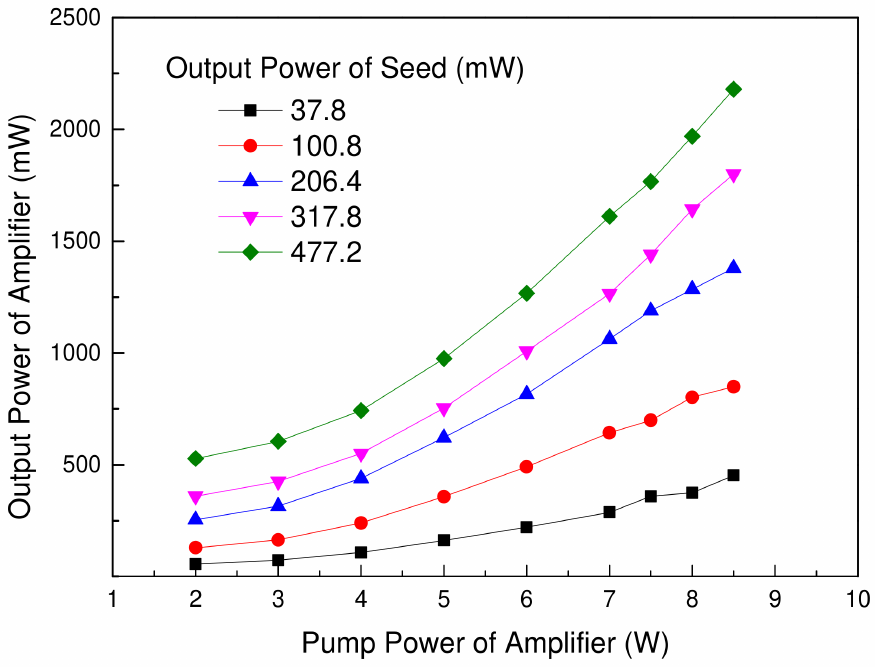
Figure 4. The amplified power of the fundamental amplifier versus the power of the seed and the input pump power of the